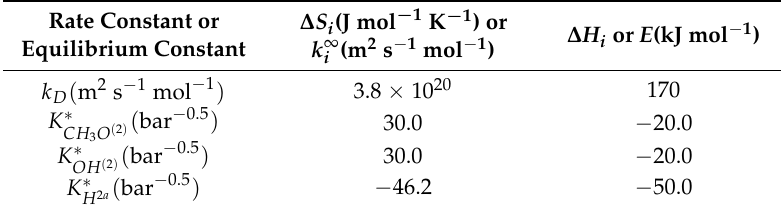
Table 2. Variables of the methanol decomposition kinetic